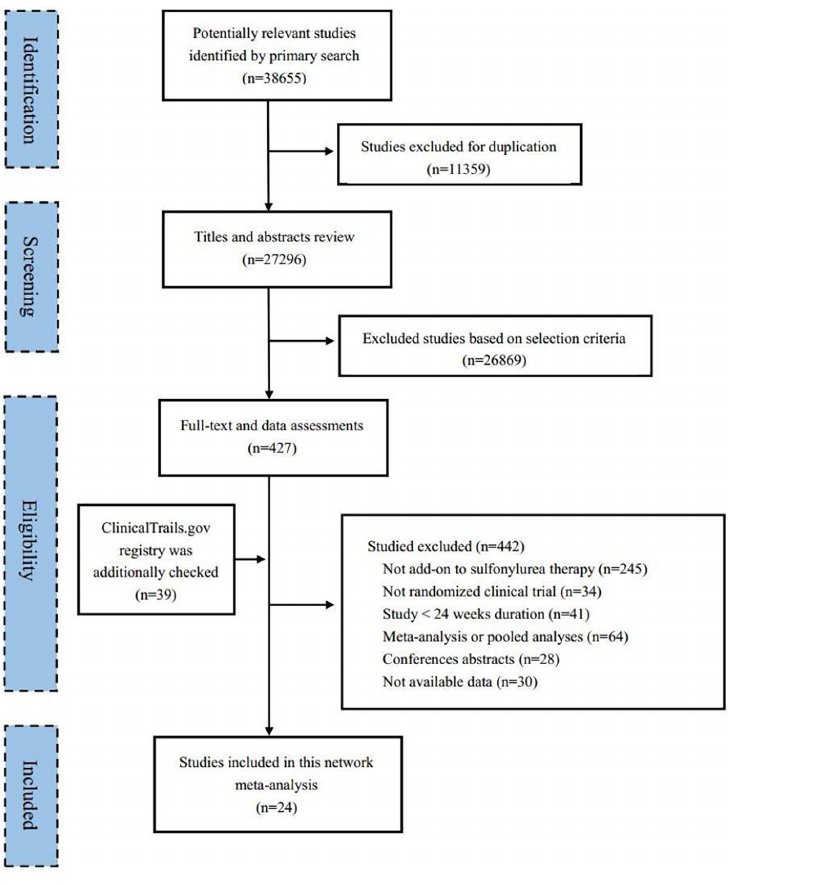
Fig 1. Flow chart of the search for eligible